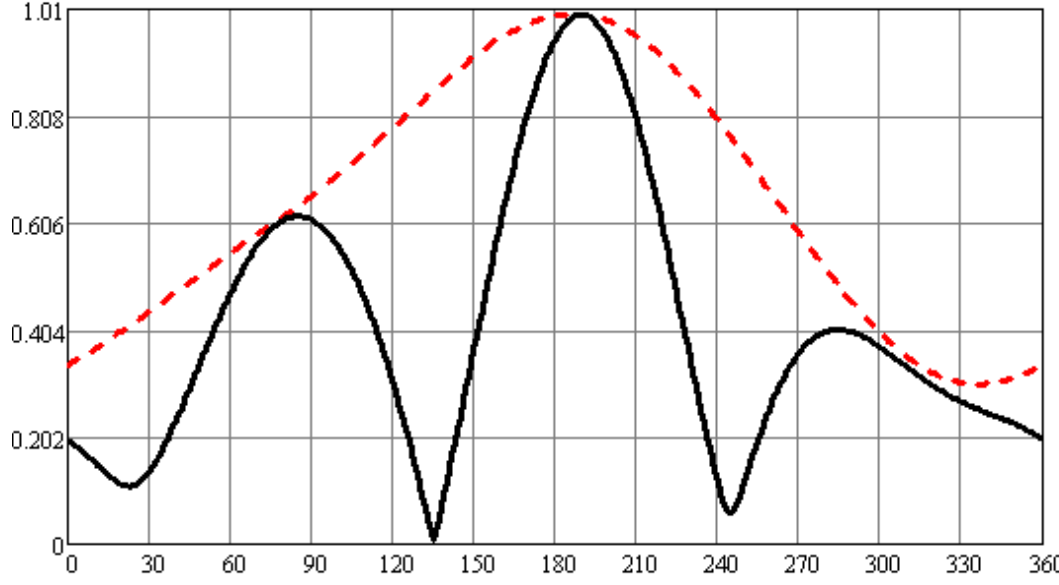
solid lines—VAA.